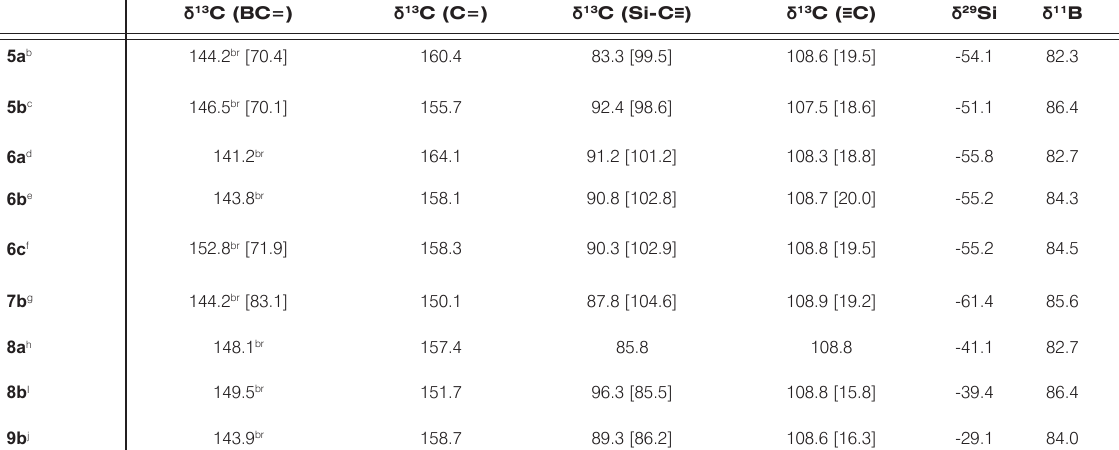
Table 1. 11 B, 13 C and 29 Si NMR data [a] of alkenyl(dialkyn-1-yl)silanes 5 - 9